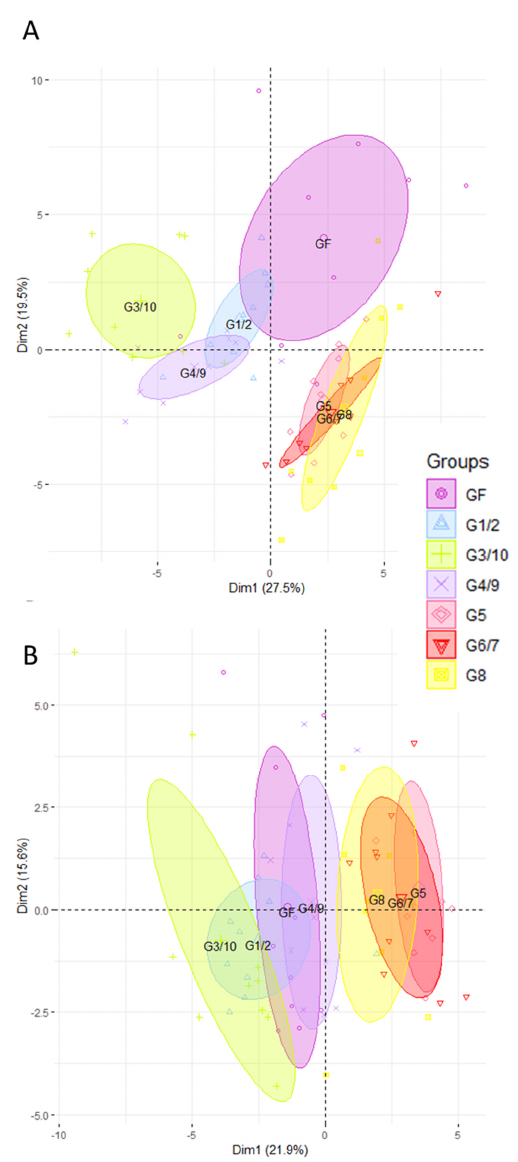
Figure 1. The ileal and colonic gene expression differs according to which genotype of Symbioflor2 ® is administered. Ileal ( A ) and colonic ( B ) gene expression was analyzed in mice mono-associated with one of the six Symbioflor2 ® genotypes (G1/2, G3/10, G4/9, G5, G6/7, G8) and in germ-free (GF) mice. Rq values that represent the abundance of transcripts relative to GF group were used for principal component analysis (PCA) after trimming datasets for the least informative genes (see Section 2). In total, 56 genes were retained for PCA in the ileum and 40 in the colon; n = 10 for each group of mice.